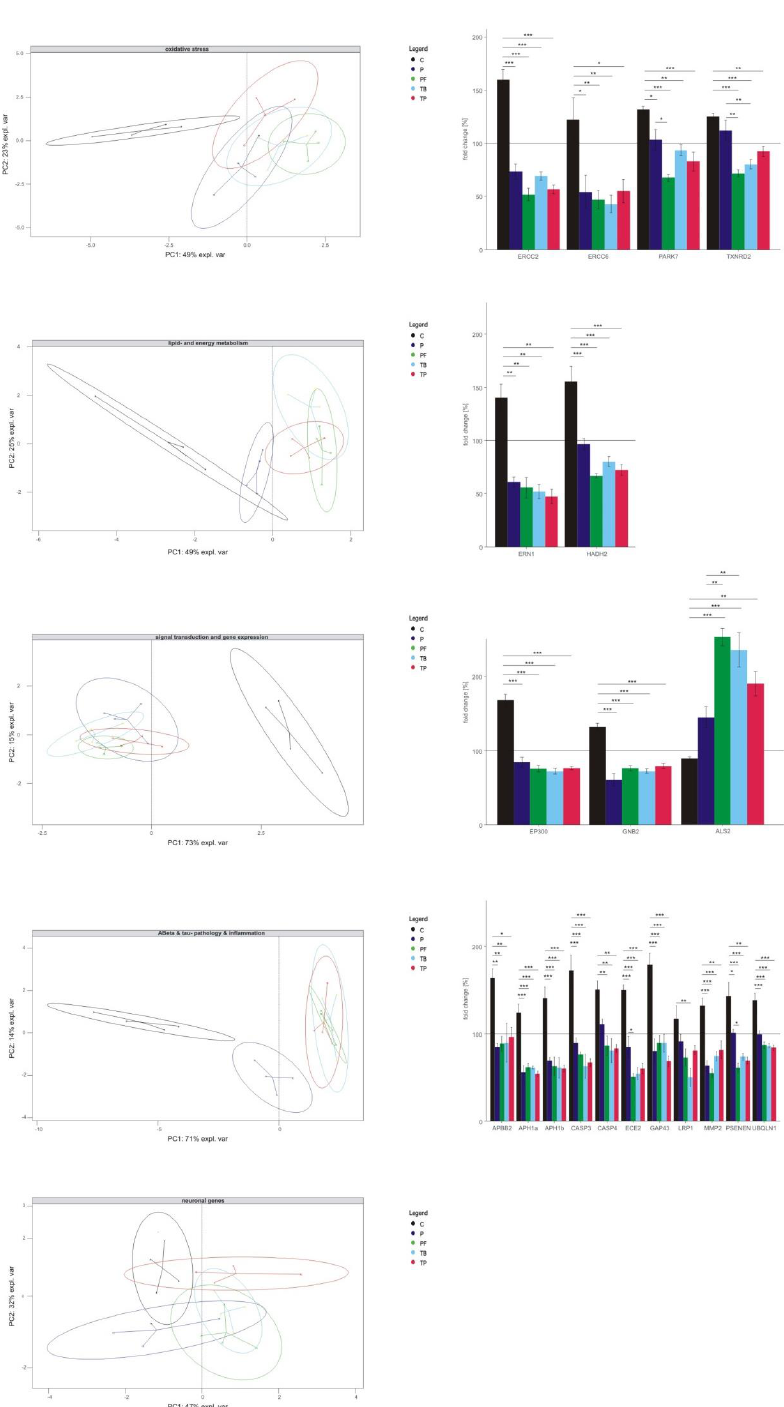
Figure 5. Comparison of the transcriptional e ff ects of ca ff eine, theobromine, theophylline, pentoxifylline and propentofylline. Results of the principal component analysis for each analyzed pathway are shown on the left. Fold changes and significances of those genes mediating the trends seen in the principal component analysis are illustrated in a bar diagram on the right for each pathway. Standard error of the mean is shown by the error bars and significance was calculated by Tukey’s honestly significant di ff erence (HSD) post-hoc test and set as * p ≤ 0.05, ** p ≤ 0.01 and *** p ≤